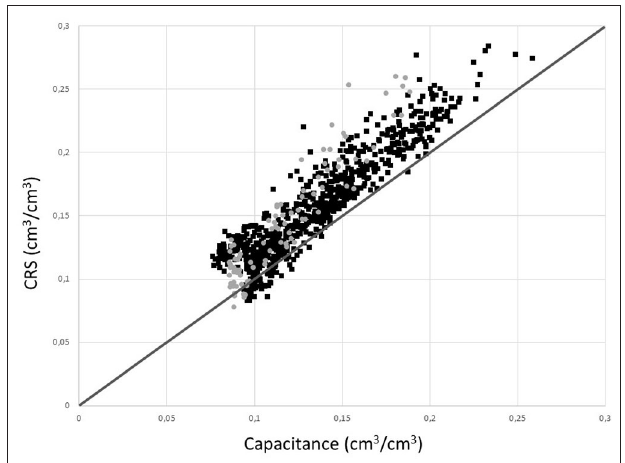
FIGURE 5 | Comparison of soil water content values measured using capacitance and CRNP probes at the T (black squares) and C (gray circles) plots after the vegetation